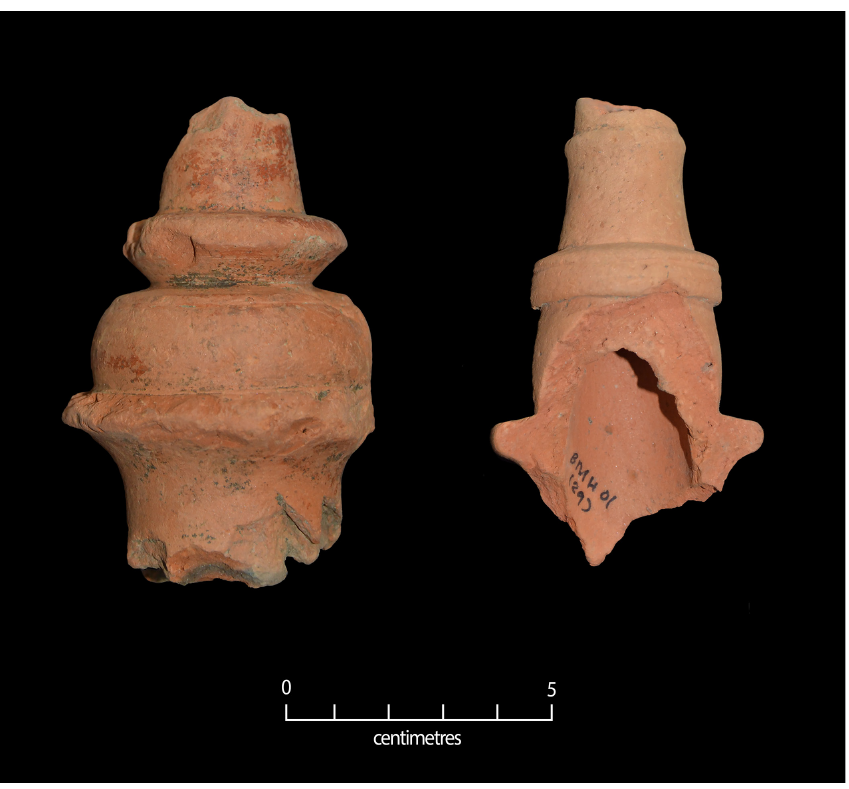
Figure 3: Examples of narrow necked vessels (‘sprinklers’) identified as Class 1 variant 1.